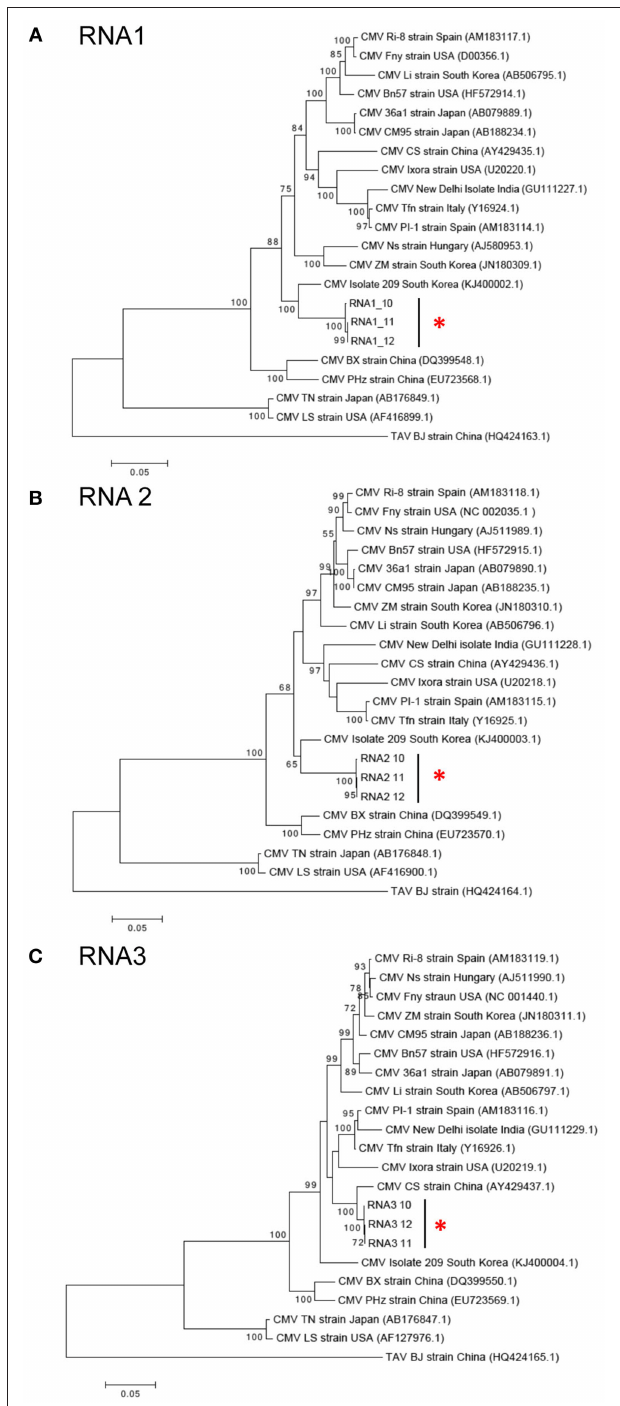
FIGURE 4 | (A–C) Phylogenetic analysis of cucumber mosaic virus (CMV) RNAs 1, 2, and 3 of the Kenyan strain with other CMV strains and isolates from diverse plant hosts. The phylogeny was based on aligning 2,994 nucleotide bases of the RNA1, 2,079 nucleotide bases of the RNA2 and for RNA3, an alignment of 657 nucleotide bases of the coat protein gene. The evolutionary history was inferred by the Maximum likelihood method based on the Tamura Nei model with 1,000 bootstraps in MEGA version 6. Placement of the three isolates from samples obtained at Kirinyaga is indicated by